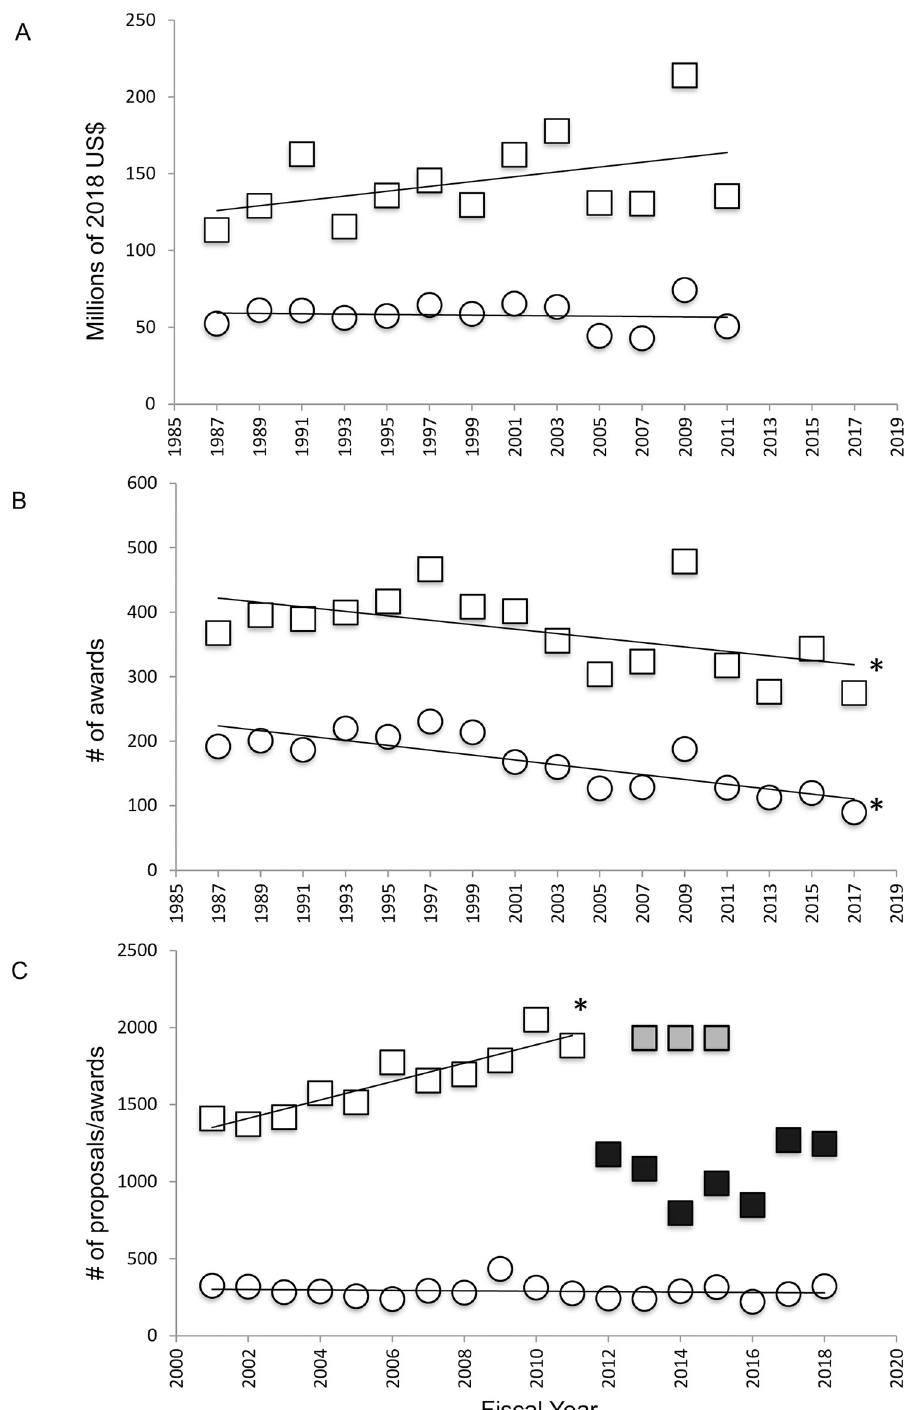
Fig 2. Grant funding by NSF IOS and by neurobiology and behavior programs, and grant success rates for IOS. A. Total 2018 US$ awarded every other year from FY1987- FY2011 by the IOS division (Plant Genome Project awards subtracted (IOS-PGP); squares), and neurobiological and behavioral (NBR) programs contained within IOS (circles). B. Total award numbers made every other year from FY1987- FY2017 by IOS-PGP (squares) and NBR programs (circles). C. Full proposals submitted to IOS from 2001–2011 (open squares), estimated preproposals submitted from 2013–2015 (light grey squares), invited full proposals submitted from 2012–2018 (black squares) and total grants funded from 2000–2018 (open circles). Asterisks in B indicate significant decrease in IOS-PGP and NBR award numbers. Asterisk in C indicates significant increase in IOS proposals